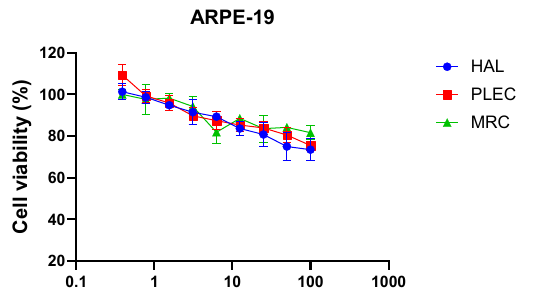
Figure 3. Effects of HAL, PLEC and MRC on the viability of ARPE-19 cells as determined by the MTT assay after 24 h. Values represent the means ± SD as percentage (%) of control values. Values on the X -axis are shown as log10.